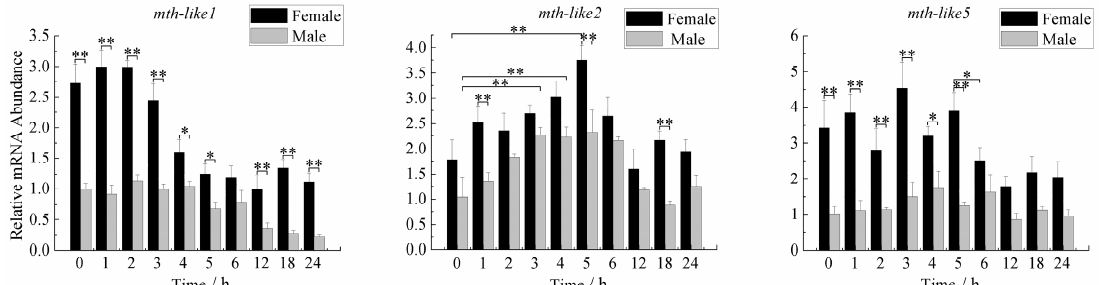
Figure 6. Expression profiles under oxidative stress. The relative expression indicates the level of each mth-like transcript normalized to the internal standard of α -tubulin, compared to expression levels of the first group (0 h). 0–24 h means different time under the oxidative stress. Data are shown as the mean ± SD. Asterisks indicate differences that are statistically significant (*, p < 0.05; **, p < 0.01).